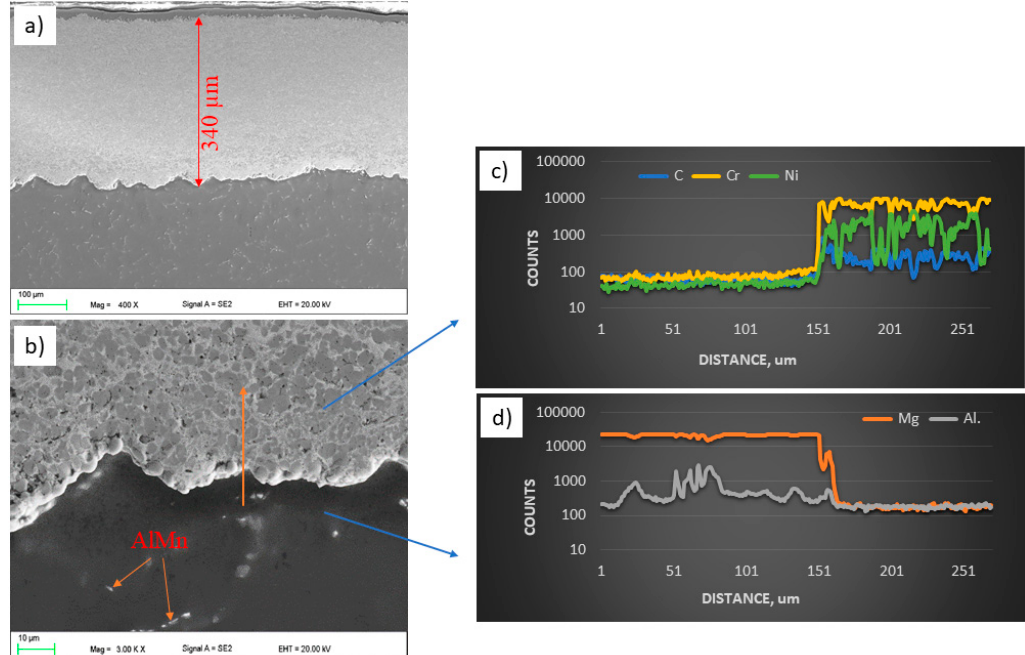
Figure 4. Structure ( a , b ) and results of the chemical analysis along the line from Figure b ( c , d ) of the CrC coating. The microstructures shown in Figures 3a and 4a indicate uniform, compact, and SEM micrographs and point element analysis as well as the area distribution showed layered coatings [32,33]. The average thickness of the coatings obtained as a result of spherical unmelted and semi-melted carbide particles (dark grey (Cr 3 C 2 ) and white (WC) HVOF spraying was about 162 ± 18 µ m for WC and 344 ± 12 µ m for CrC. The thickness of areas in Figure 5) in a metallic nickel matrix. A similar phenomenon was observed by Dent et al. [37].